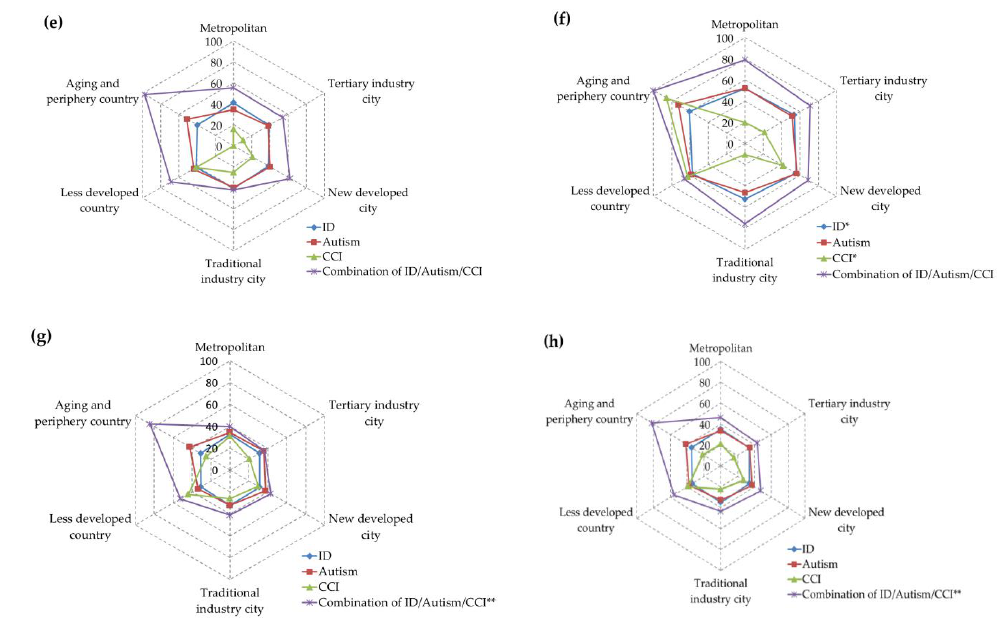
Figure 2. The performance functioning scores of WHODAS 2.0 between different urbanization: ( a ) Domain 1, Cognition; ( b ) Domain 2, Mobility; ( c ) Domain 3, Self-care; ( d ) Domain 4, Getting along; ( e ) Domain 5-1, Life activities: household; ( f ) Domain 5-2, Life activities: work and school task; ( g ) Domain 6, Participation and ( h ) Summary Scores. The adjusted scores significance between different urbanization and subgroups ( p < 0.05), * p <0.05;** p < 0.01; *** p < 0.001.